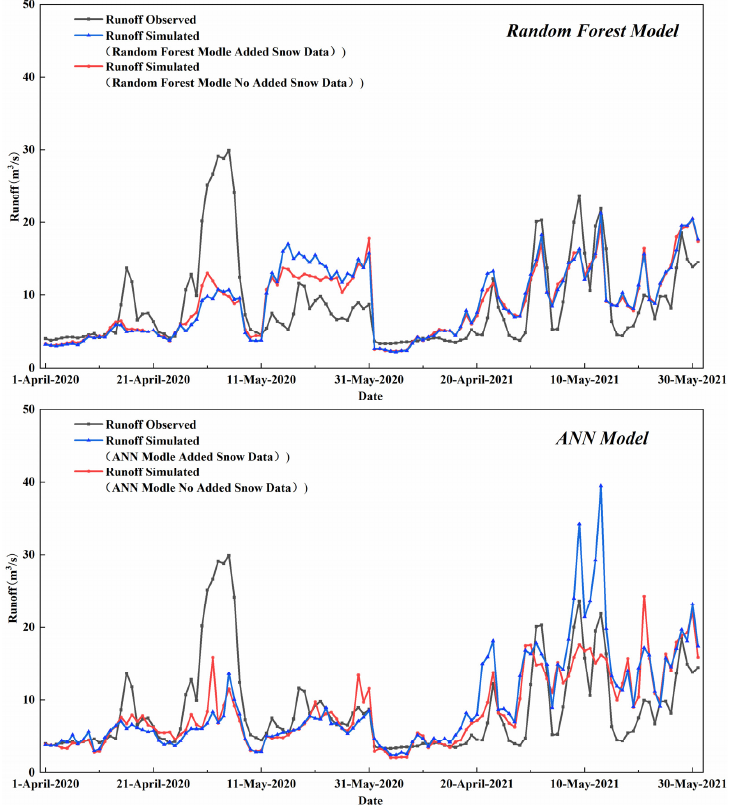
Figure 6. Simulation results for the random forest model and ANN model of the Xiying River Basin from April to May, 2020 to 2021. Table 5. Verification results for the random forest model and ANN model of the Xiying River Basin from April to May, 2020 to 2021. Model